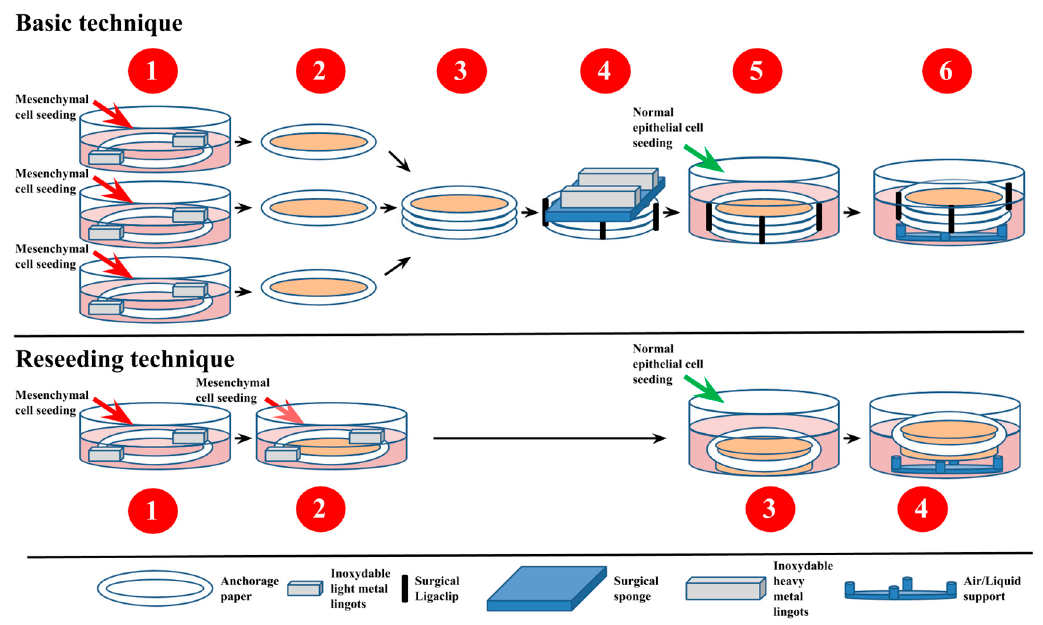
Figure 6. Schematic description of the basic and the reseeding self-assembly techniques used in Tissue Engineering. For the basic self-assembly technique, mesenchymal cells are seeded into three cell culture dishes containing a paper anchor and rust-resistant light metal weights at the bottom. After 28 days in culture with ascorbate, the stromal sheets formed are stacked upon each other for a variable time with a mechanical load composed of a surgical sponge and rust-resistant heavy metal ingots and with surgical Ligaclips to ensure the fusion of the sheets. Epithelial cells are seeded on top of the construct, and the culture is continued for seven more days. After that, tissues are mounted onto supports and maintained at the air / liquid interface for 21 consecutive days to ensure a complete maturation of the epithelium. The first step for the reseeding self-assembly technique is similar to the one for the classic self-assembly technique. However, instead of stacking the stroma sheets later, mesenchymal cells are reseeded on top of the stroma sheets after 14 days of culture with ascorbate. Fourteen days later, epithelial cells are seeded on top of the stroma sheets, and the culture is continued for an additional seven days. The tissue constructs are then maintained at the air / liquid interface with support for 21 days to ensure a complete maturation of the epithelium [108].